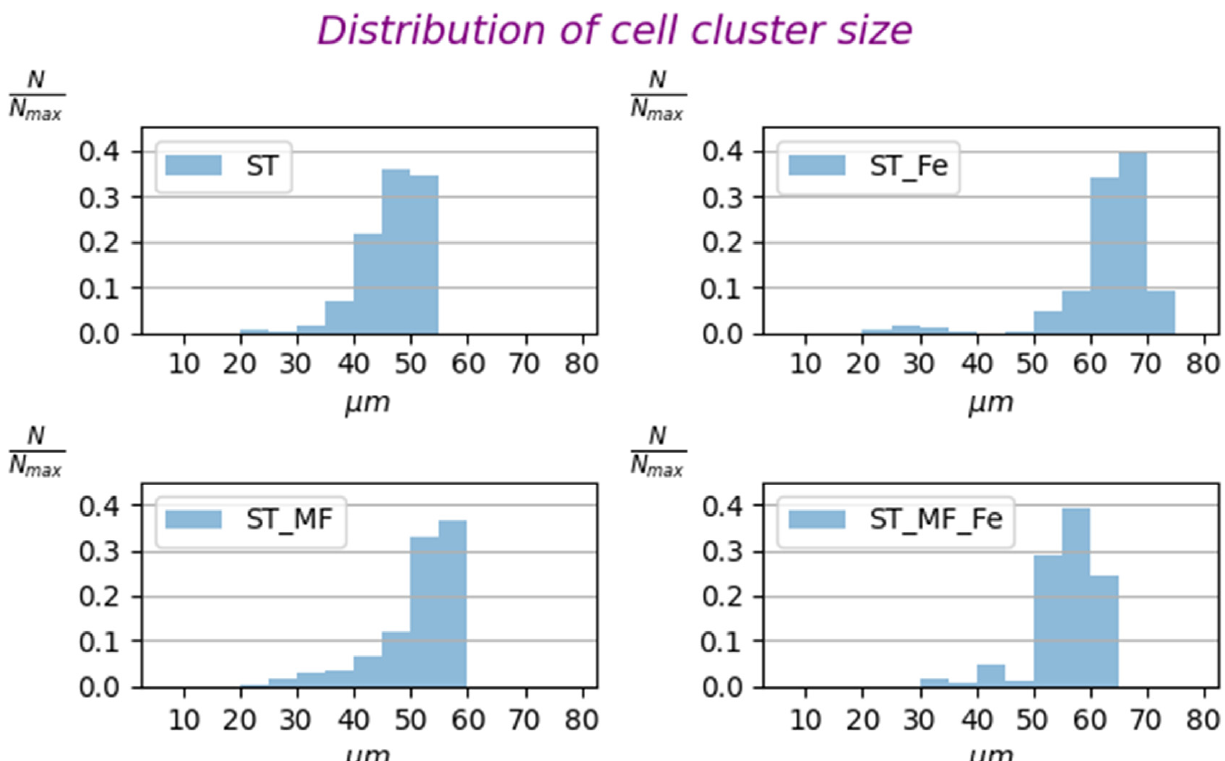
Figure 8. Distributions of the cell cluster sizes of EcN bacteria: N is the number of bacterial cell clusters, and N max is the total number of bacterial cell clusters analyzed. ST—standard medium (control), ST + Fe—standard medium with iron chelates, ST + MF—standard medium in the gradient 0.15 T MF, ST + MF + Fe—standard medium with iron chelates in the gradient MF of 0.15 T. The x -axis refers to the size of bacterial cell clusters in the suspension used to study magnetophoretic ve-